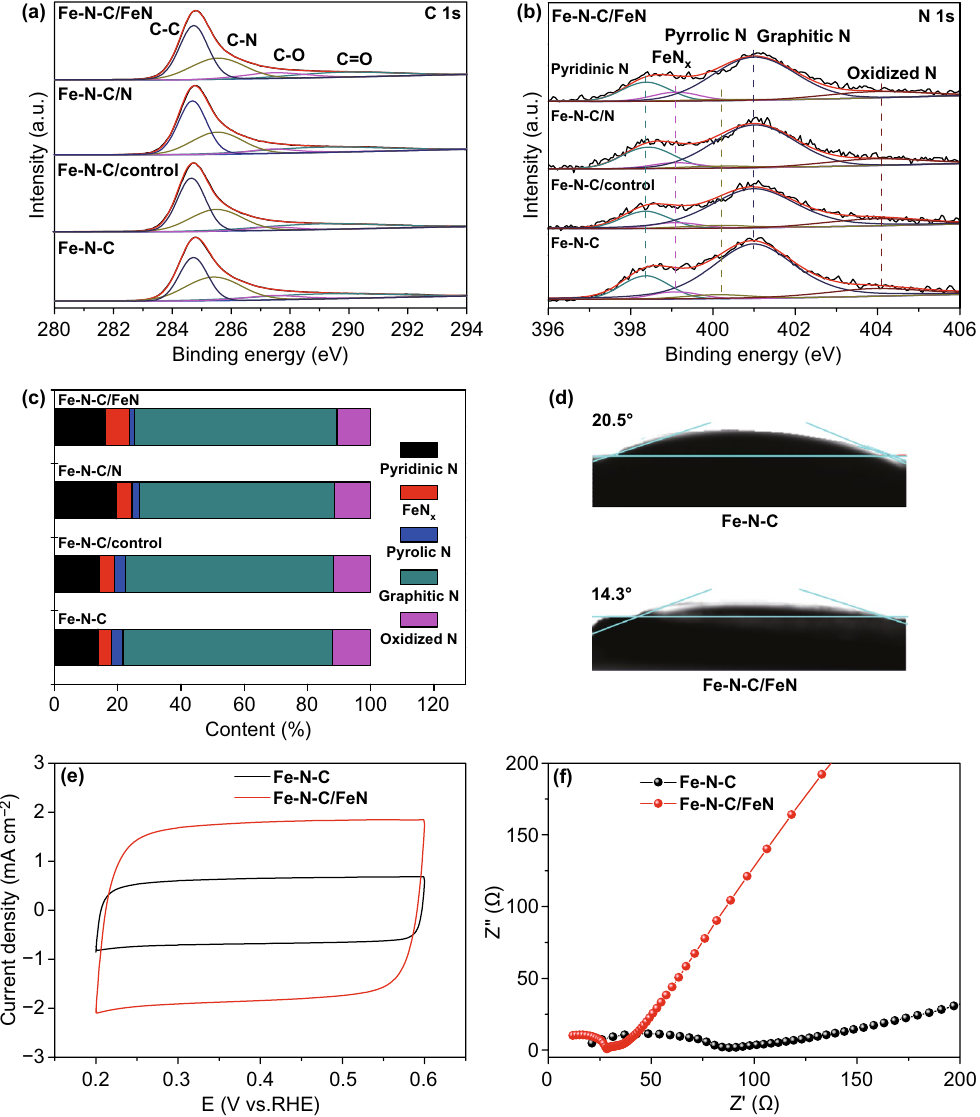
Fig. 3 a C 1s, b N 1s XPS spectra, and c corresponding contents of different N species of the resultant catalysts. d Water contact angle of Fe– N–C and Fe–N–C/FeN. e Cyclic voltammetry curves in N 2 -saturated HClO 4 solution (sweep rate: 10 mV s −1 ). f EIS curves of Fe–N–C and Fe–